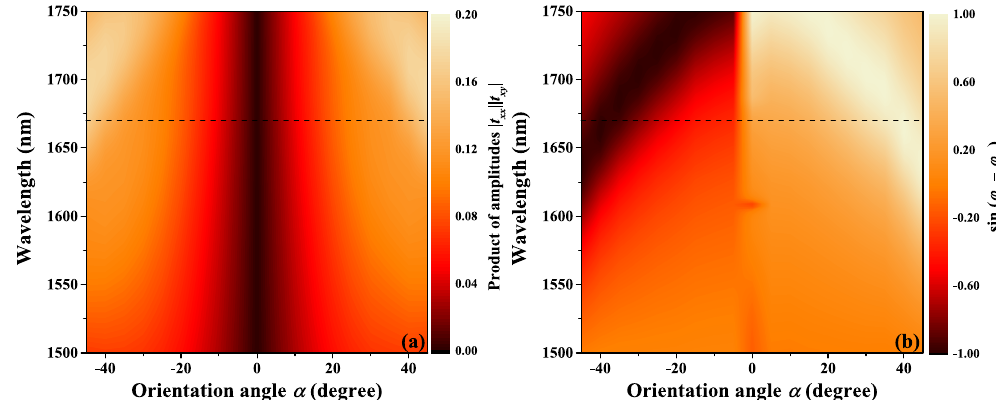
Figure 6. The relationship between the chiral response of the designed metasurface and its orientation angle. Simulation results for two-layer metasurfaces with different orientation angles and wavelengths. ( a ) Products of amplitudes | t xx |·| t xy | for the linear base transmission coefficients t xx and t xy . ( b ) Sine value of phase difference − ϕ ϕ xy xx .